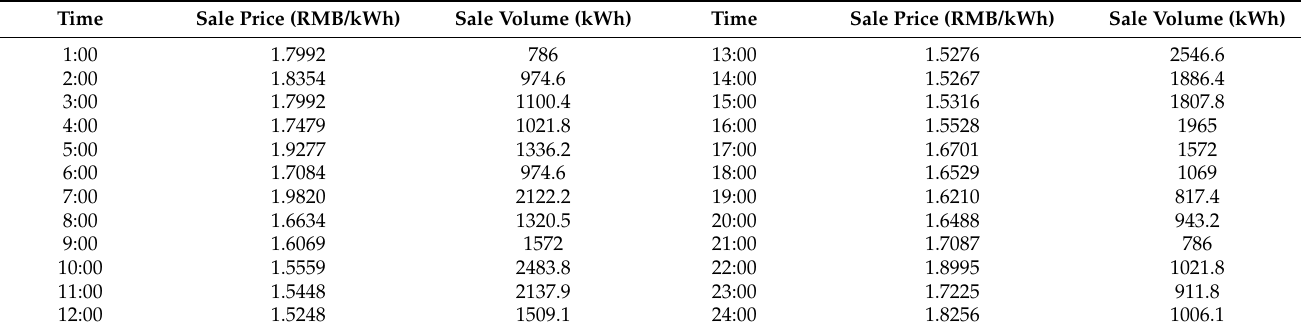
Figure 9. Optimal results of dynamic hydrogen pricing for DES 0. Table 3. Hydrogen transaction information for DES 0.